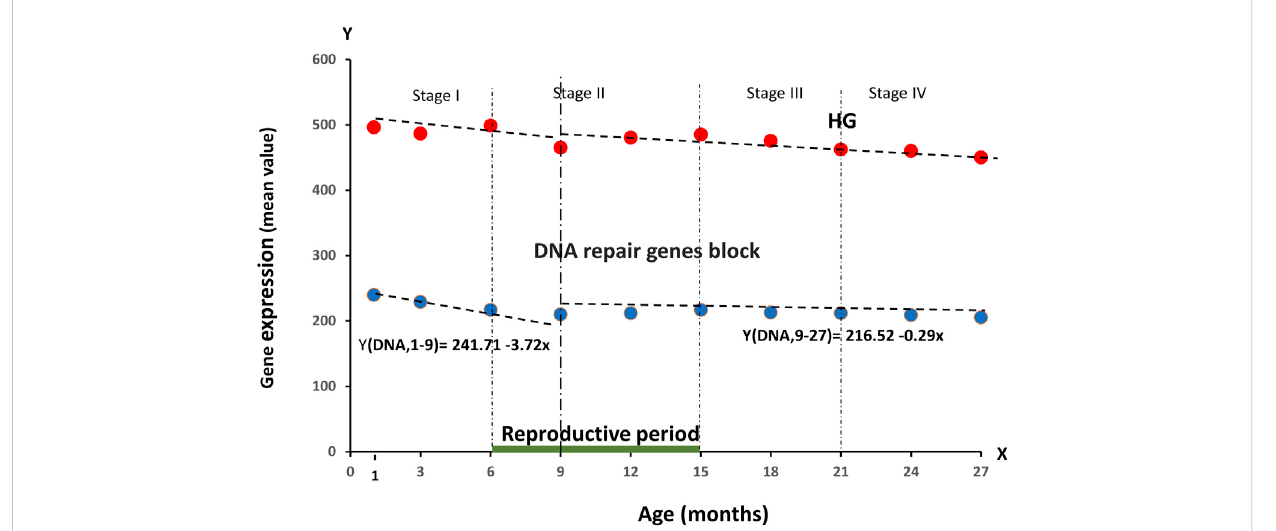
FIGURE 4 Dynamics of RNA production values in blocks of genes regulating ontogenesis ( Block I : and Block II) during the observation period of age, divided into four stages of ontogenesis — Stage I (1 – 6 months), Stage II (6 – 15 months), Stage III (15 – 21 months), Stage IV (21 – 27 months).